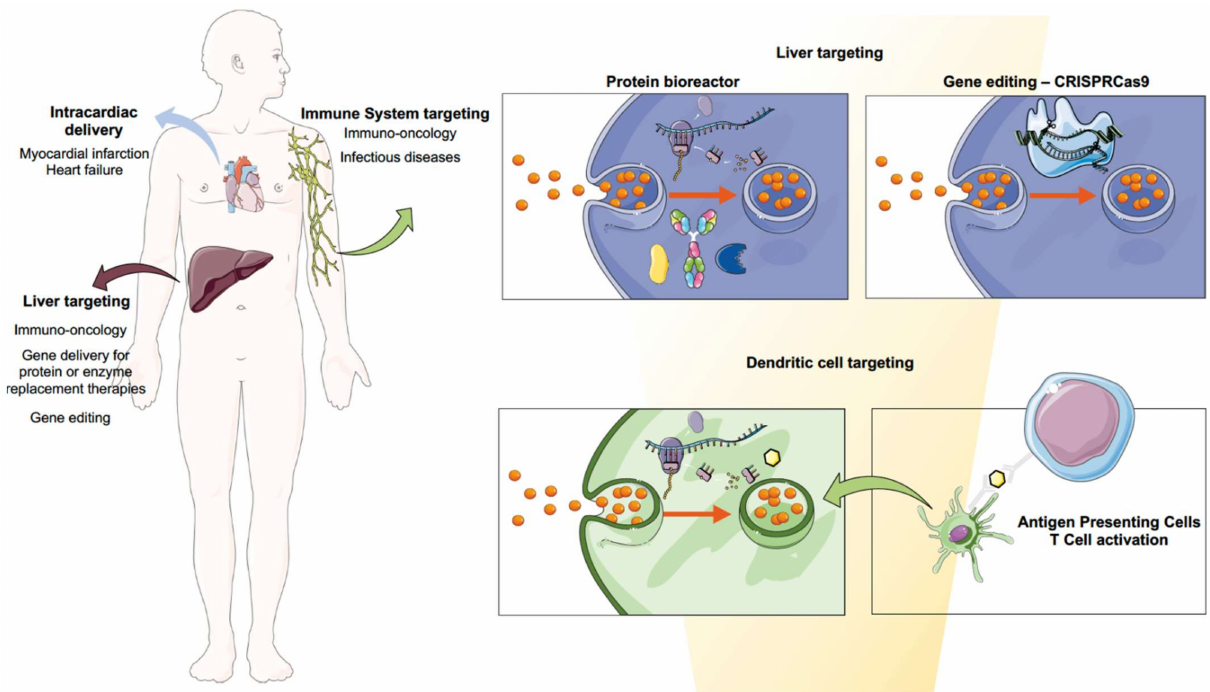
Figure 4. Biomedical applications for mRNA therapeutics. Immuno-oncology treatments can be envisioned using the liver as a factory of therapeutic proteins such as neoantigens or antibodies, as well as by using the antigen-presenting cells’ physiological function to induce immune activation towards cancerous cells. The latter can also be applied for the development of safe and efficacious mRNA and saRNA vaccines against infectious diseases. Gene delivery for therapeutic protein synthesis or restoration of a particular enzymatic function as well as gene editing using CRISPR cas9 technology can be achieved by targeting the liver. Cardiovascular regeneration can be achieved by intracardial delivery of mRNA encoding for growth